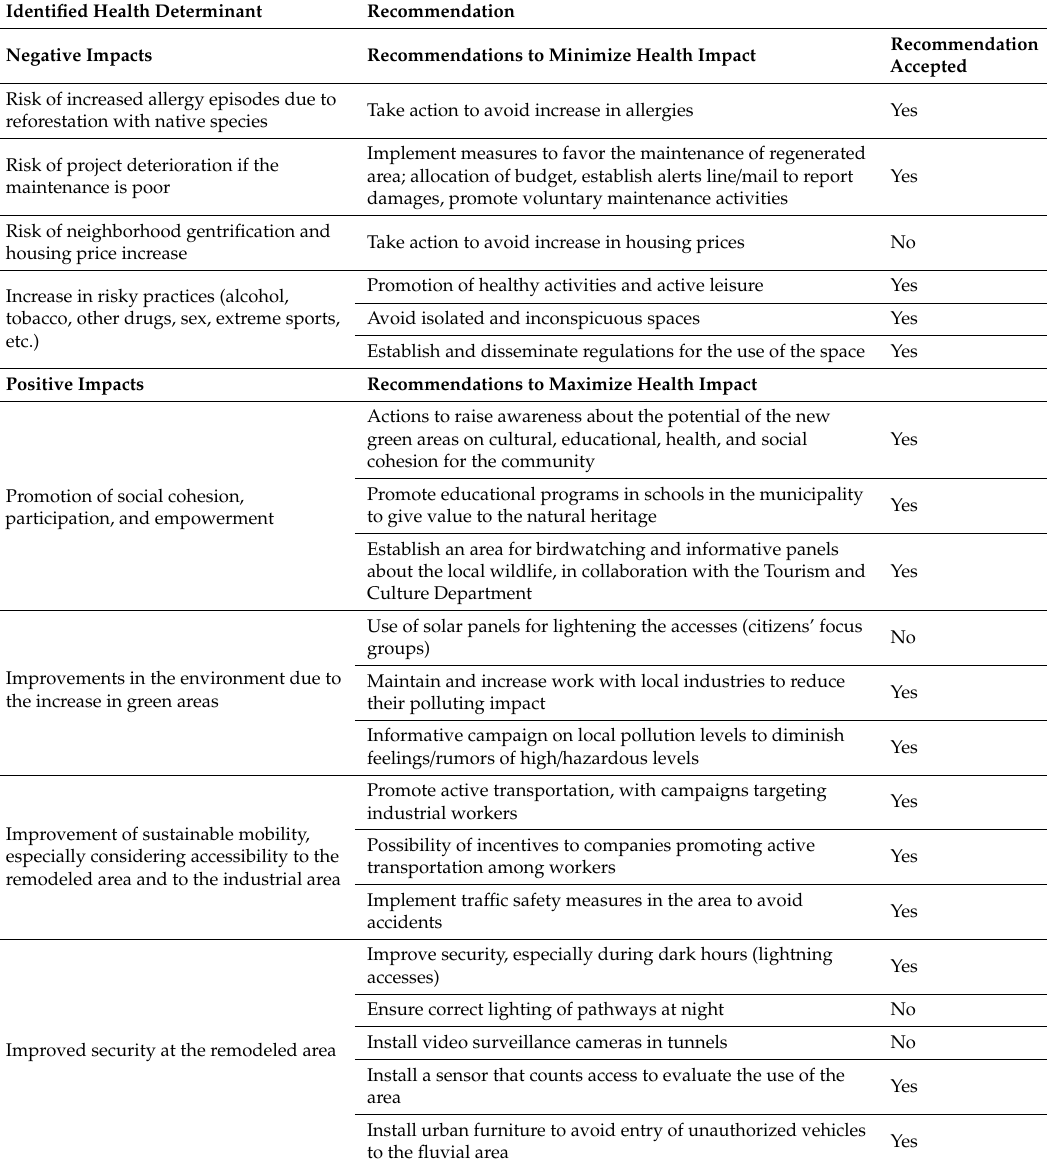
Table 3. Prioritized impacts and related recommendations to minimize / maximize health